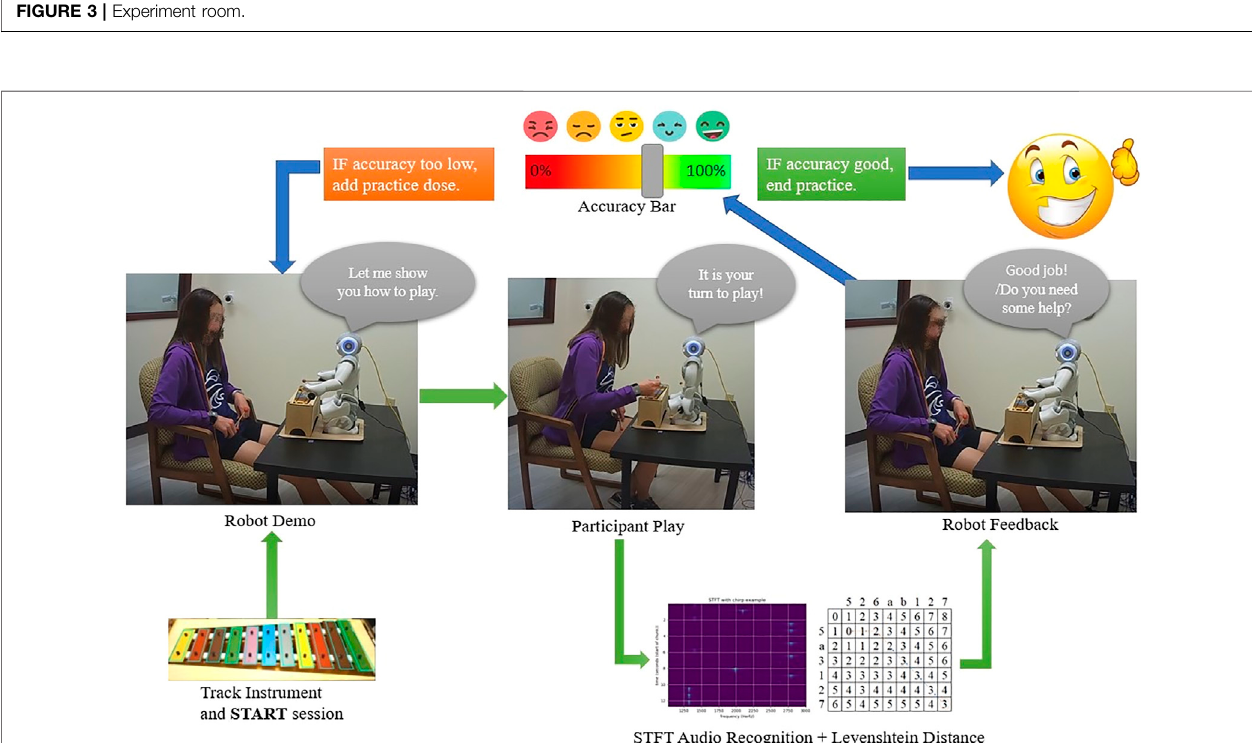
FIGURE 4 | Experiment session